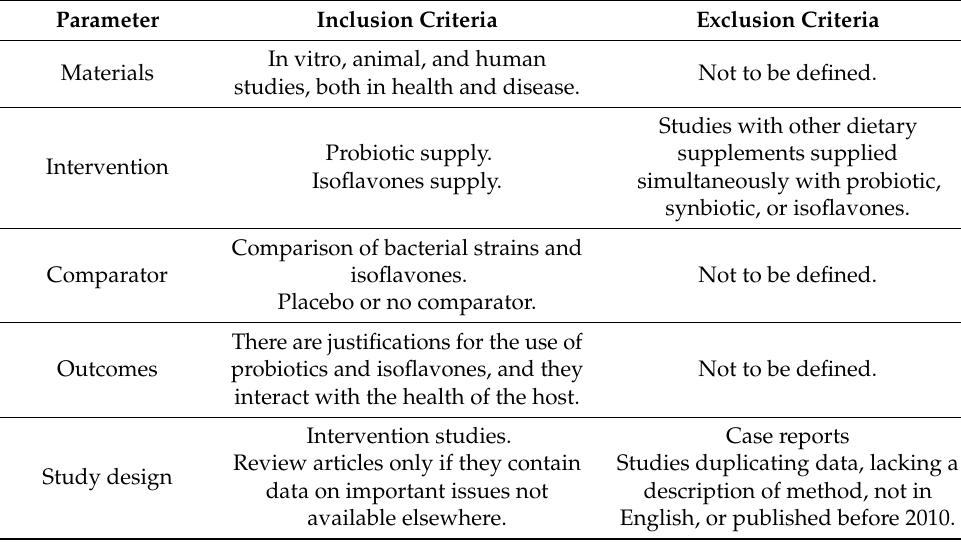
Table 2. Study inclusion and exclusion